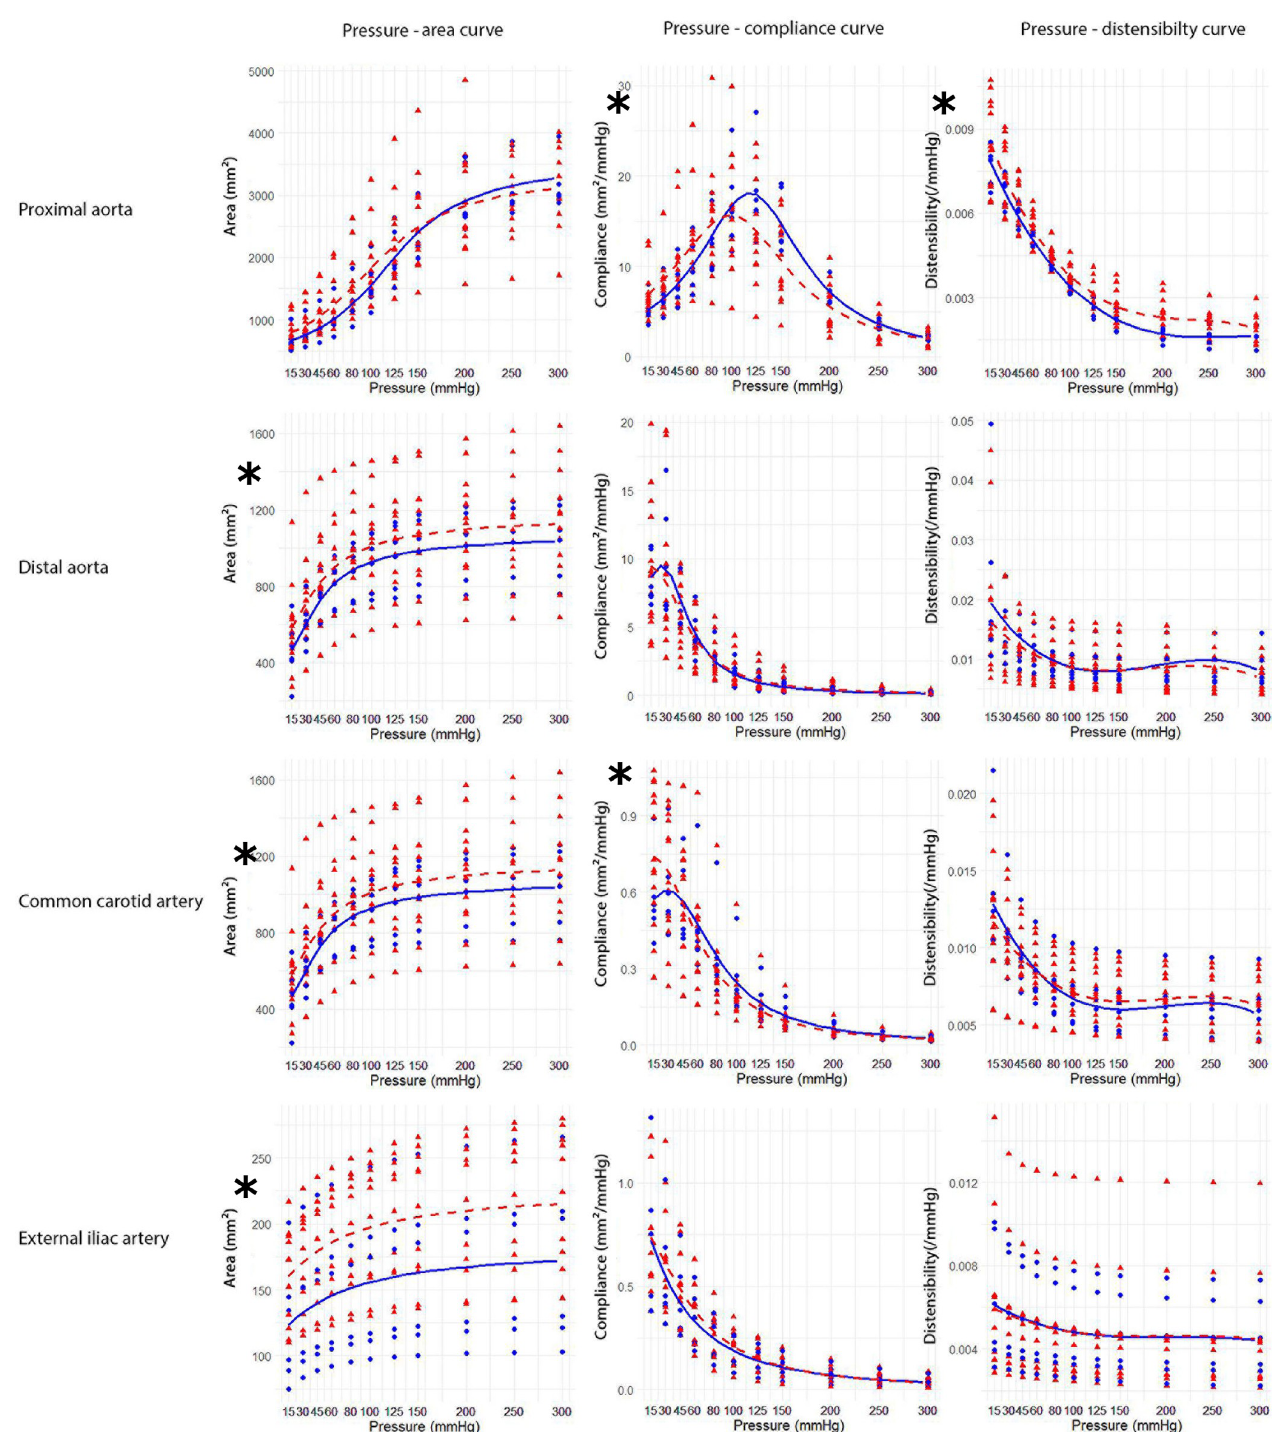
Fig 8. Pressure-area, pressure-compliance and pressure-distensibility curves of the proximal aorta, distal aorta, common carotid artery and external iliac artery in young (blue) and old horses (red). Dots and triangles represent individual values of young and old horses, respectively; full lines and dotted lines represent the fitted regression curves of young and old horses, respectively. Asterisks indicate a significant difference between old and young horses for the pressure-area, pressure-compliance or pressure-distensibility curves.